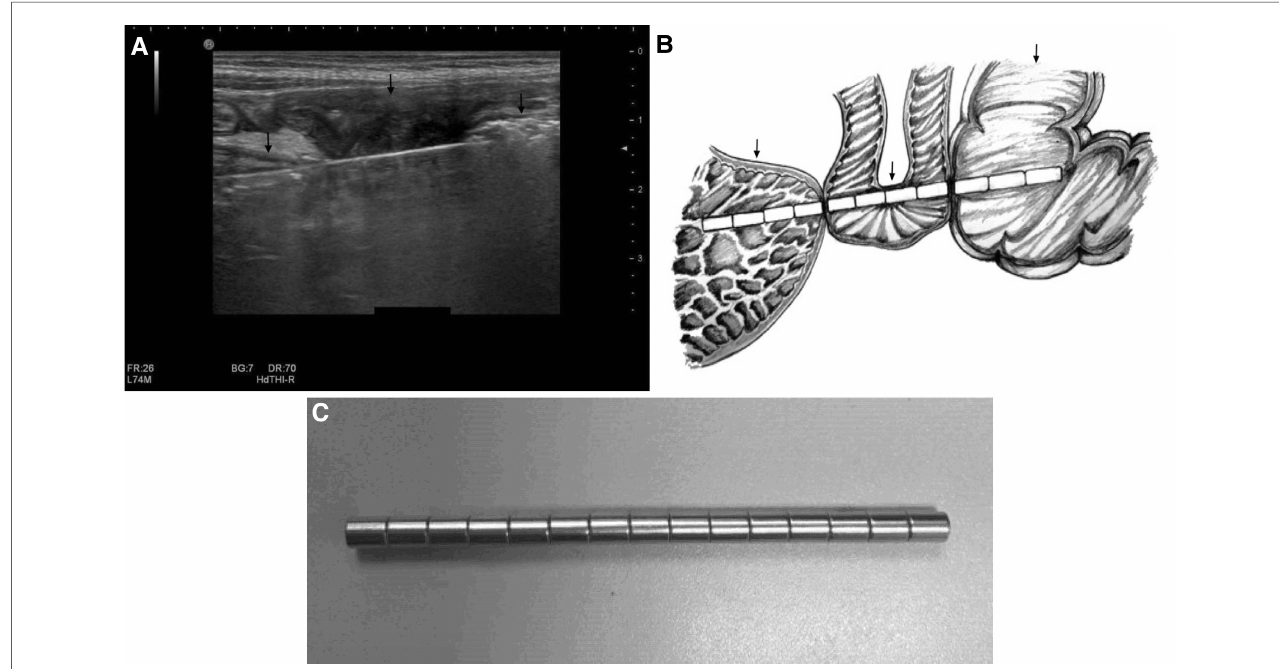
FIGURE 5 Multiple magnets in the gastrointestinal tract of a 2-year-old boy. A strong, long linear-shaped echo with a comet tail sign, representing multiple magnets attracted to one another, is seen in the stomach (left black arrow), small intestine (middle black arrow), and colon (right black arrow). ( A ) This indicates wall entrapment, which was con fi rmed by surgery. A further hand-drawn schema is presented to illustrate the position and surrounding conditions of the magnets. ( B ) Photograph of multiple magnets taken during surgery ( C ).